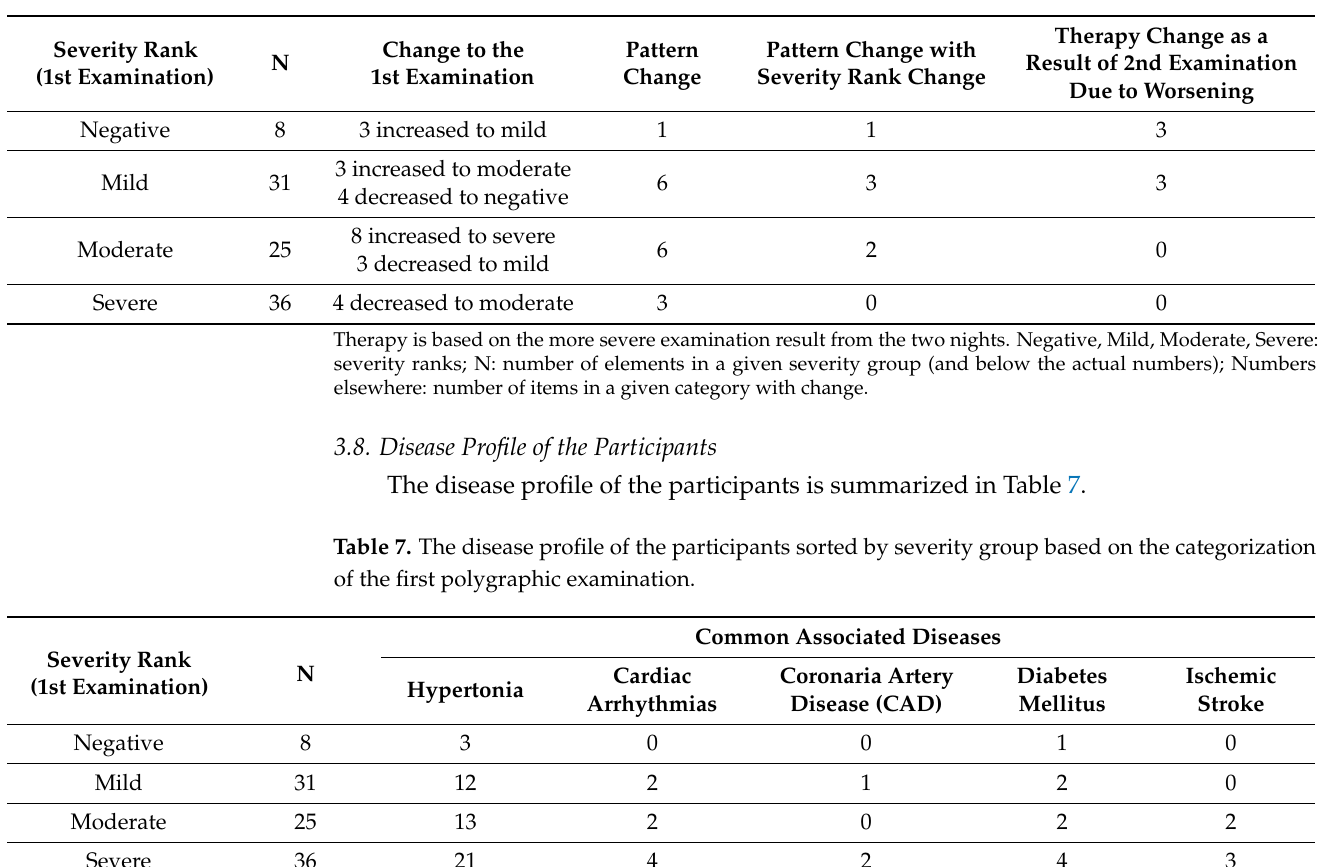
Table 6. Severity rank, pattern, and therapy changes based on the second polygraphic examination.